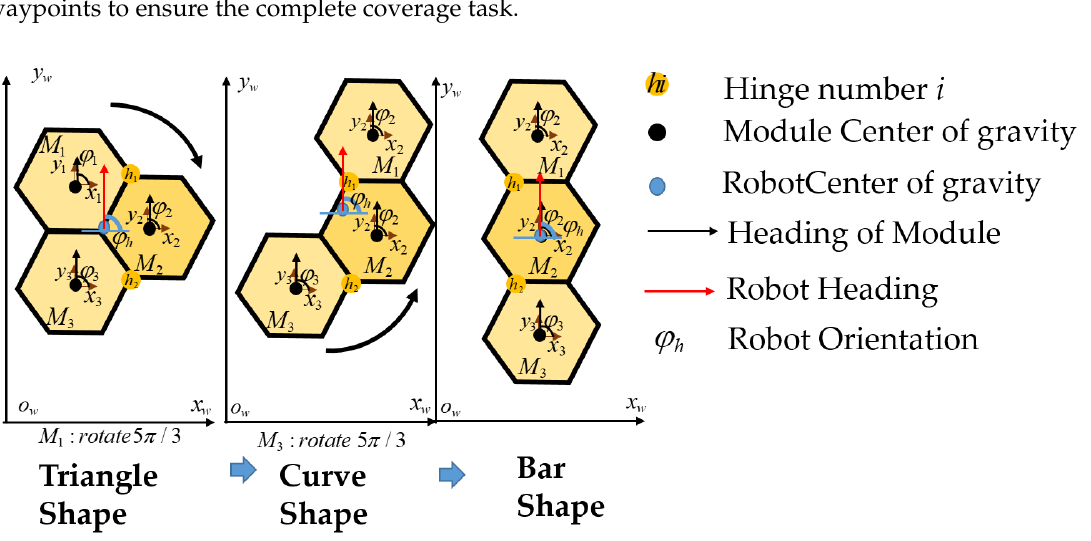
Figure 4. Description of hTrihex inside the workspace with shape shifting, heading, and